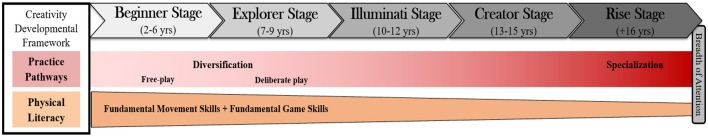
The type of practice pathway and physical literacy structure embodied in creativity training stages.